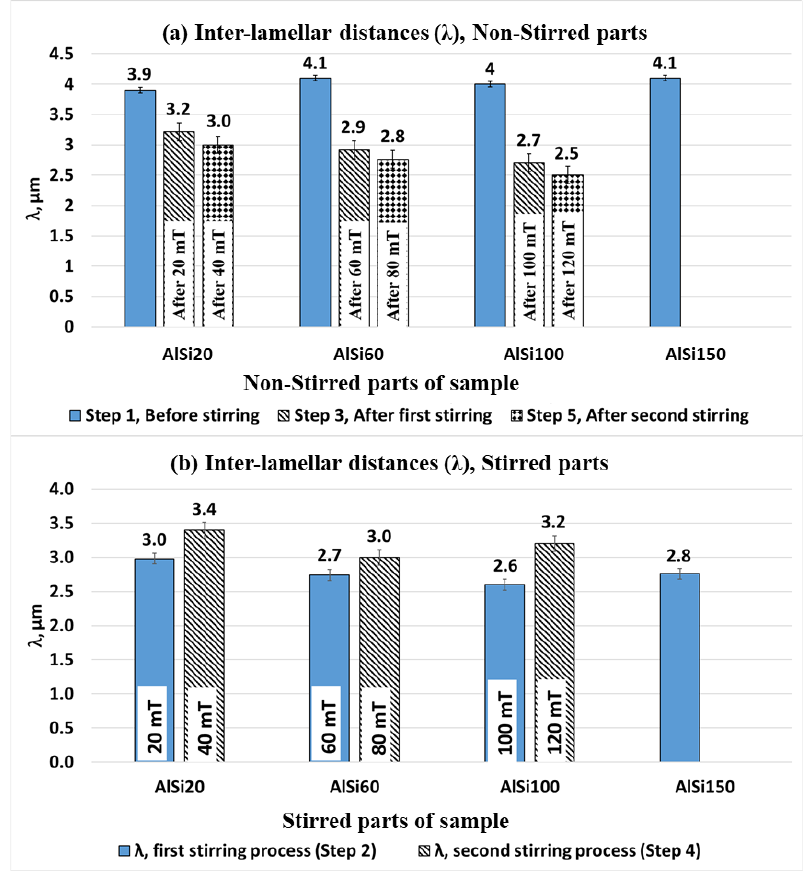
Figure 4. Inter-lamellar distance measurements. ( a ) Non-stirred parts, Steps 1, 3, and 5, ( b ) stirred parts, Steps 2 and 4.